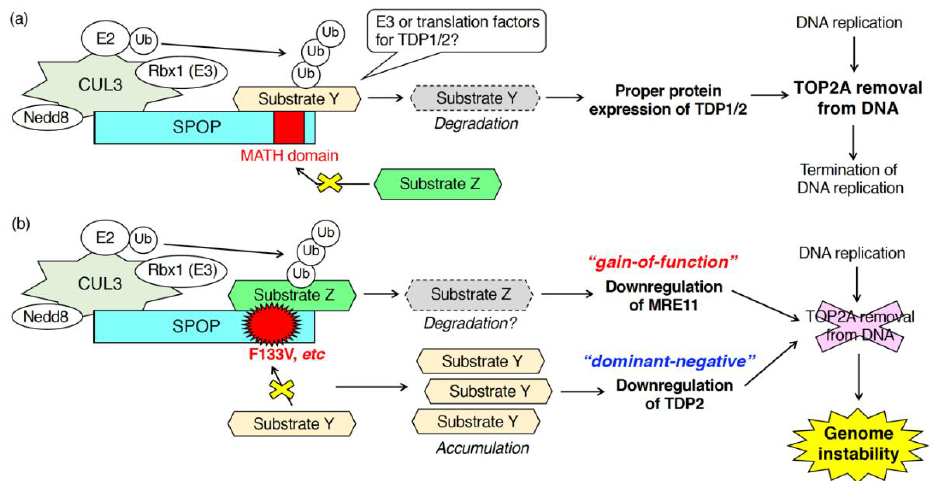
Figure 4. Patho-physiological roles of SPOP in DNA–protein crosslink repair during DNA replication. SPOP functions in the elimination of TOP2A from the TOP2A-DNA cleavage complex. ( a ) In cells expressing wild-type SPOP, the proper protein expression of TDP1 and TDP2 requires SPOP leading to the TOP2A removal from DNA. ( b ) In cells expressing F133V mutant of SPOP, the mutant serves as a dominant-negative and gain-of-function mutant in the downregulation of TDP2 and MRE11, respectively.